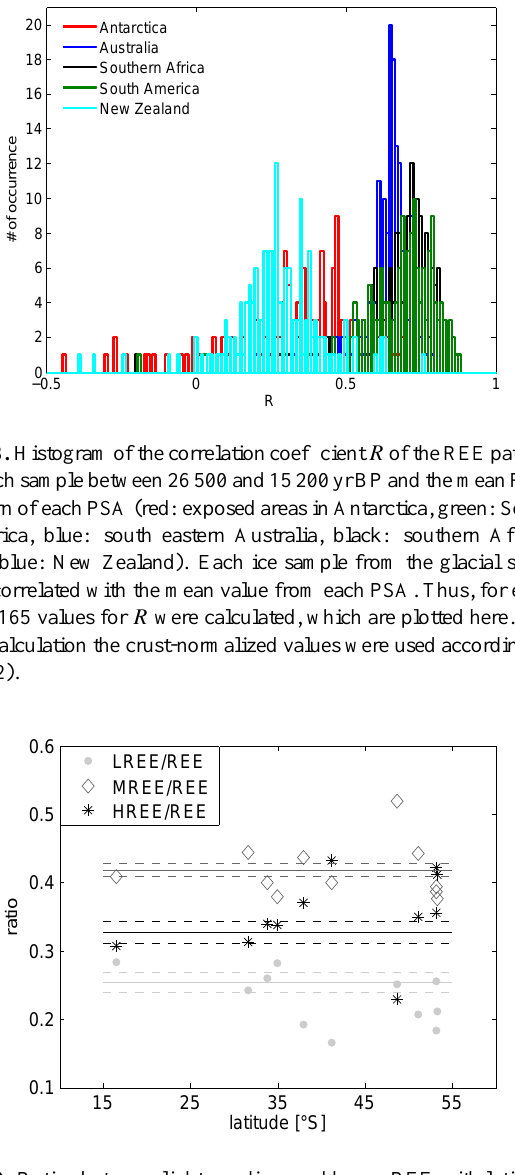
Fig. 9. Ratios between light, medium and heavy REE with latitude in South America: Horizontal lines give the mean glacial values with 1 σ standard deviation (dashed line) (upper line MREE/REE, middle line HREE/REE and bottom line